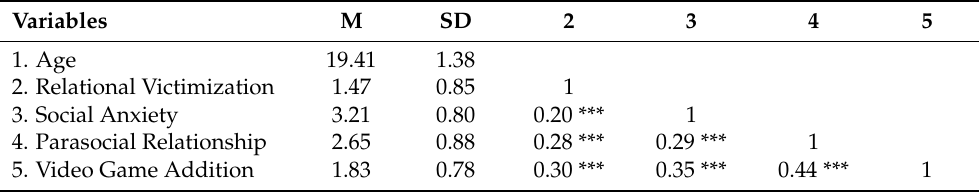
Table 1. Descriptive statistics and correlations of the main studied